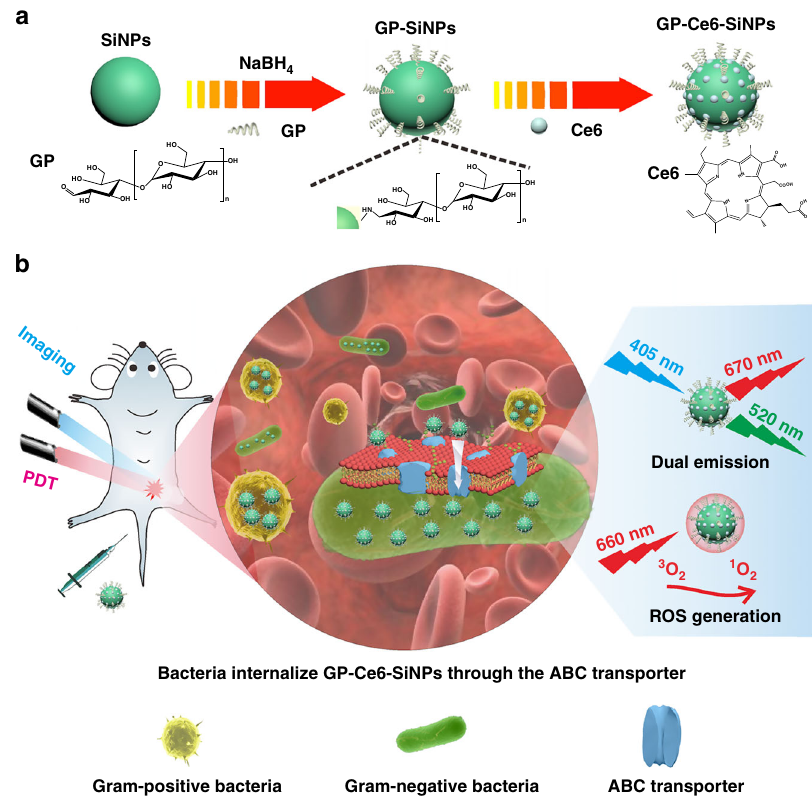
Fig. 1 Design of multifunctional nanoagents for detection and photodynamic treatment of bacterial infections. a Synthetic route of nanoagents of GP-Ce6- SiNPs. GP-Ce6-SiNPs are composed of SiNPs conjugated to GP and loaded with Ce6 molecules. b Imaging and treatment of Gram-negative and Gram- positive bacterial infections by GP-Ce6-SiNPs. GP-Ce6-SiNPs are robustly internalized by ABC transporters, which are only present in bacterial cells while not present in mammalian cells. Under 405-nm excitation, GP-Ce6-SiNPs exhibit two typical emission maxima peaks at 520 nm (assigned to SiNPs) and 670 nm (assigned to Ce6). Under 660-nm irradiation, ROS of 1 O 2 is produced from Ce6, triggering PDT against bacteria. The cartoons are created by